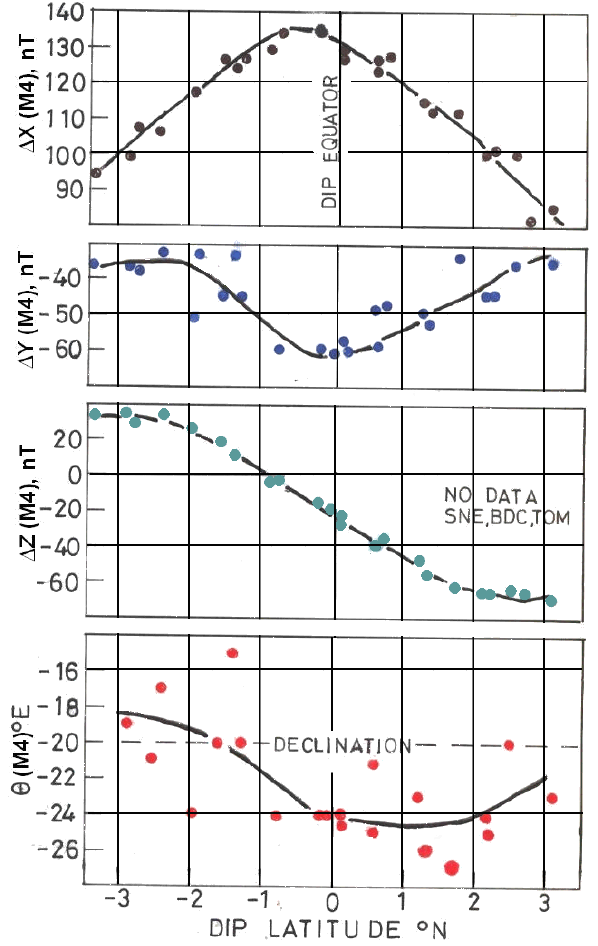
Fig. 6. Dip latitudinal variations of four hourly (10–13h) mean daily ranges of 1X (M4), 1Y (M4), 1Z (M4) and the electrojet cur- rent direction, θ (M4) averaged over all quiet days.